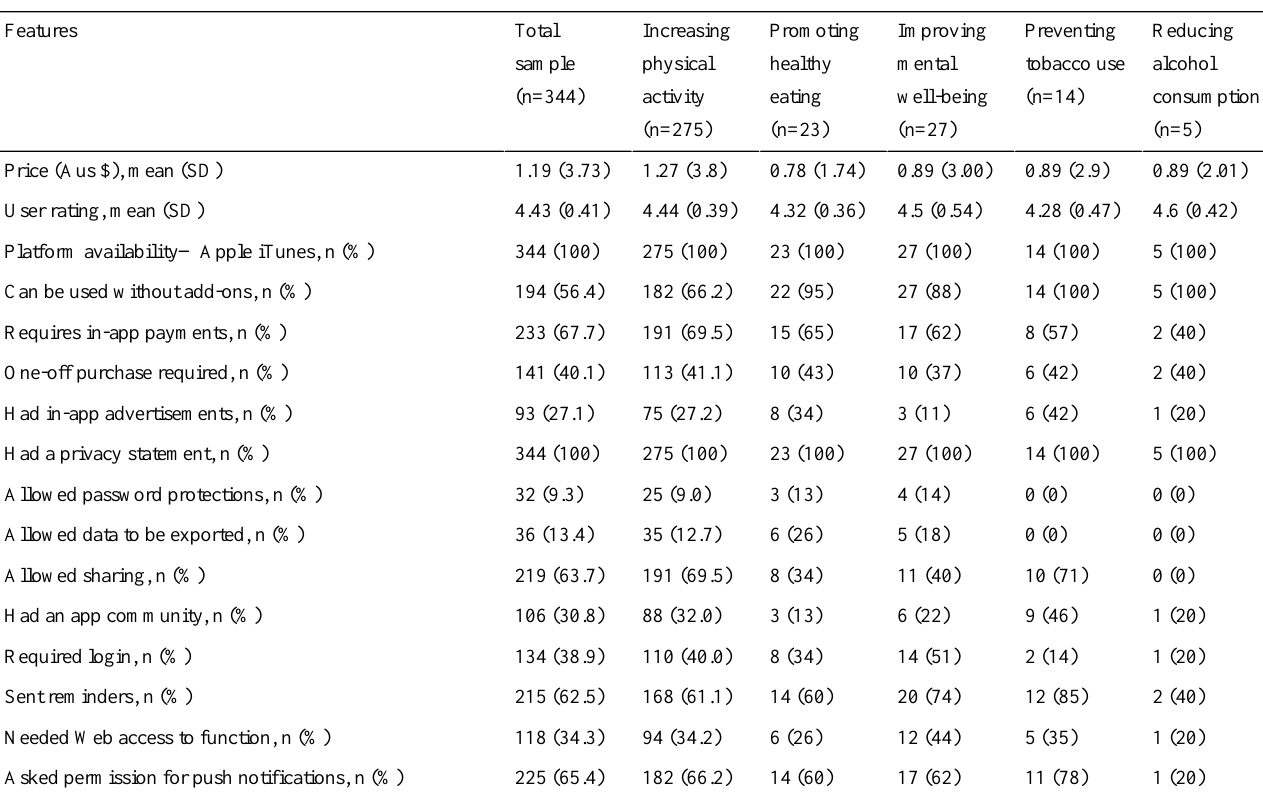
Table 1. App features.